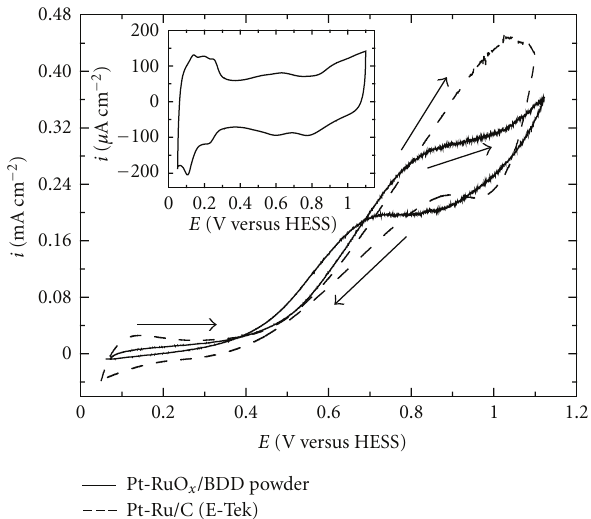
Figure 13: Cyclic voltammograms for the electrochemical oxi- dation of 0.5M of methanol in 0.5 M H 2 SO 4 aqueous solution carry out on the Pt-RuO x /BDD powder/BDD (solid line) and on the Pt-Ru/C/BDD (dashed line) electrodes at ν = 10 mVs − 1 . Insert correspond to the Cyclic voltammogram recorded on the Pt-RuO x /BDD powder/BDD electrode in 0.5 M H 2 SO 4 aqueous solution at ν = 50 mVs − 1 (reprinted with permission from [59]).